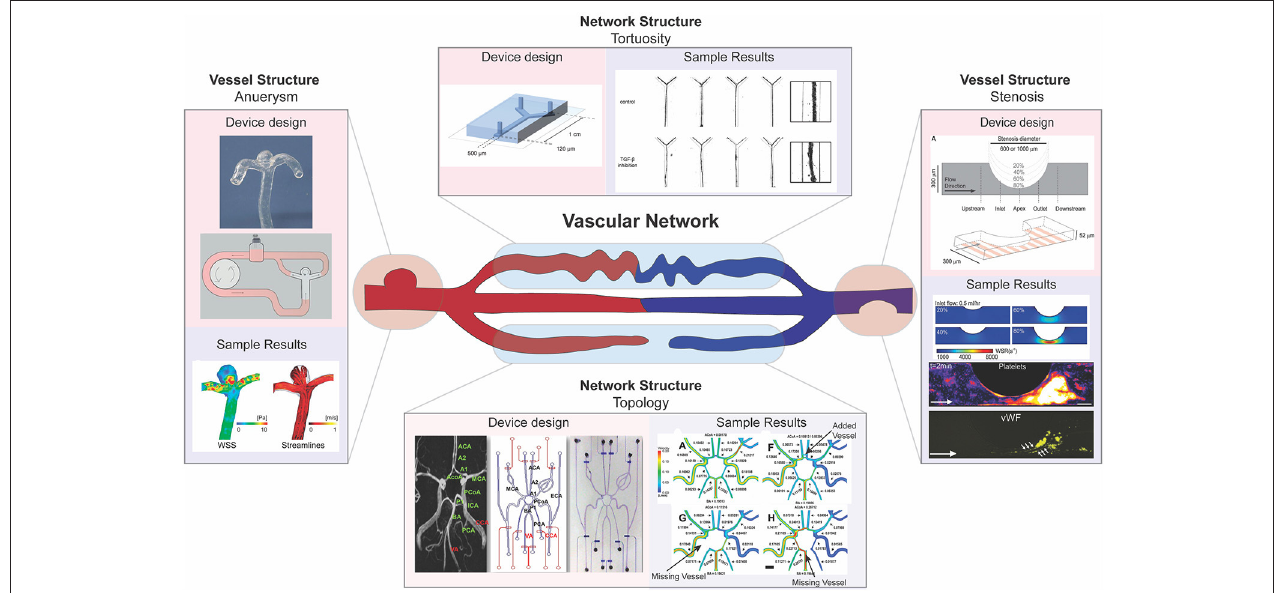
FIGURE 3 | Multi-scale modeling of pathophysiologic vascular morphology associated with vascular diseases. Microfluidic models have been developed to model pathologic alterations in vascular morphology at the vessel and network levels. Examples of investigations into focal vessel pathologies include microfluidics designed to model aneurysm (left) and stenosis (right). Examples of investigations into network pathologies include microfluidics designed to model high vessel tortuosity (top) and developmental pathologies in the circle of Willis (bottom). Functional outputs highlighted include computational fluid dynamic studies using microfluidic system morphology (left, right, bottom), quantitative and qualitative validation of vessel size and shape (top), and biochemical analysis to assess adhesion (right). [left: images reproduced from Kaneko et al. (2018) with permission from BMJ Publishing Group Ltd. Right: images reproduced from Westein et al. (2013). Top: Images republished with permission of Royal Society of Chemistry from van der Meer et al. (2013); permissions conveyed through Copyright Clearance Center Inc. Bottom: images reprinted from Nam et al. (2015), Copyright 2015, with permission from